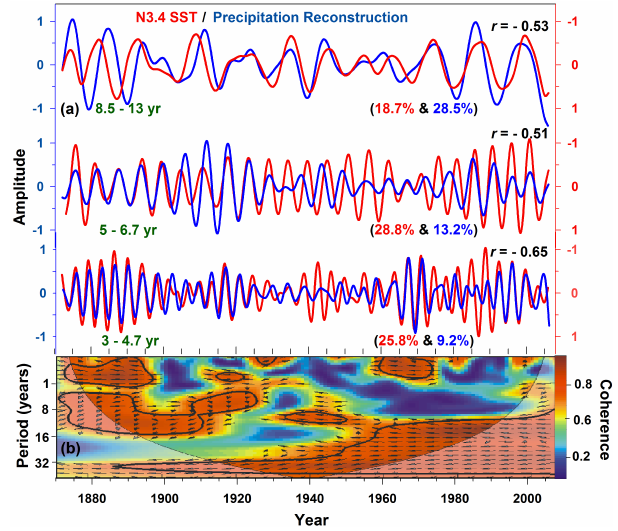
Fig. 6. Comparisons between the spectral properties of the Alti- plano precipitation reconstruction and the N3.4 SST record dur- ing the common period. Waveforms extracted by Singular Spec- trum Analysis (SSA). The frequencies for each SSA are indicated in years with green numbers, the correlation between the two se- ries at the right corner, and the percentage of variance explained by each frequency indicated in parentheses. The N3.4 SST waveforms are shown inverse to facilitate the comparison between records (a) . wavelet coherency (WTC) and phase spectrum between the Alti- plano precipitation reconstruction and the N3.4 SST. The vectors indicate the phase difference between the two records (arrows point- ing right and left correspond to in-phase and antiphase relationships, respectively). Thick black contours encircle the periods where both series were related at a significance level (95%c.l.). The cone of influence is shown at the bottom in a lighter shaded (b) .